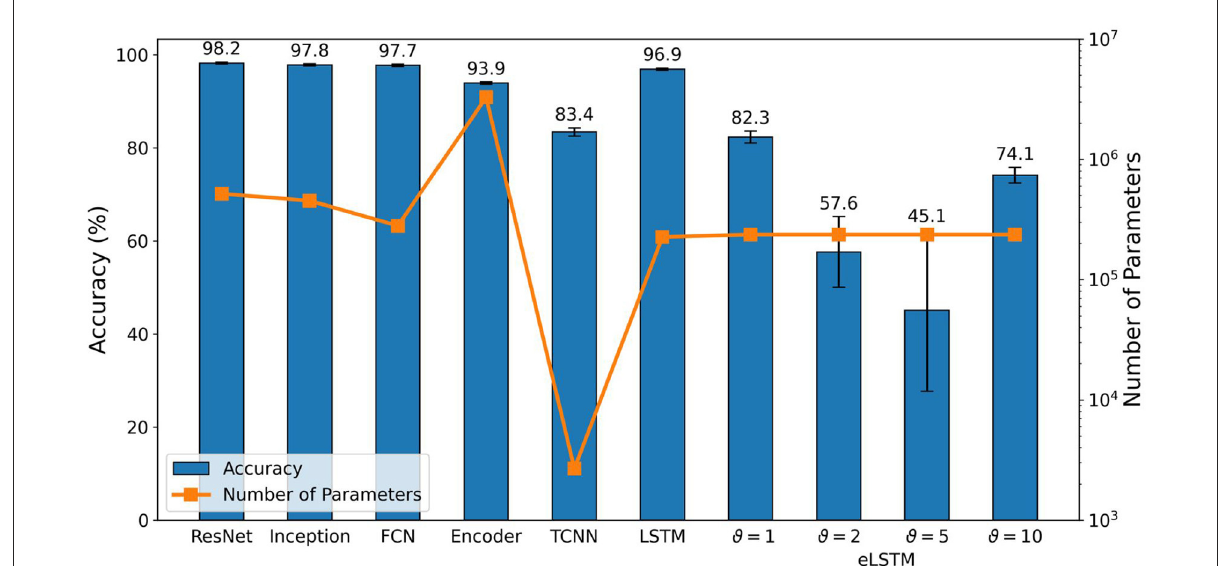
Supplementary Figure 2 the hyperparameters exploration during the first step of the HPO procedure is